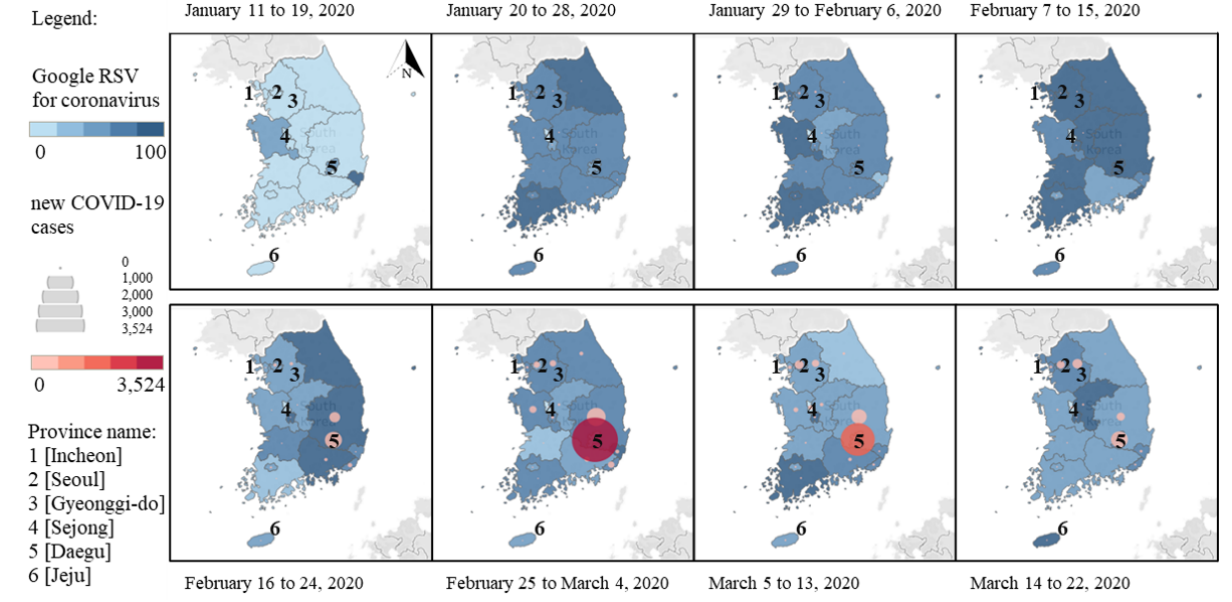
Figure 7. Distribution of new COVID-19 cases and Google Trends RSVs in South Korea. RSV: relative search